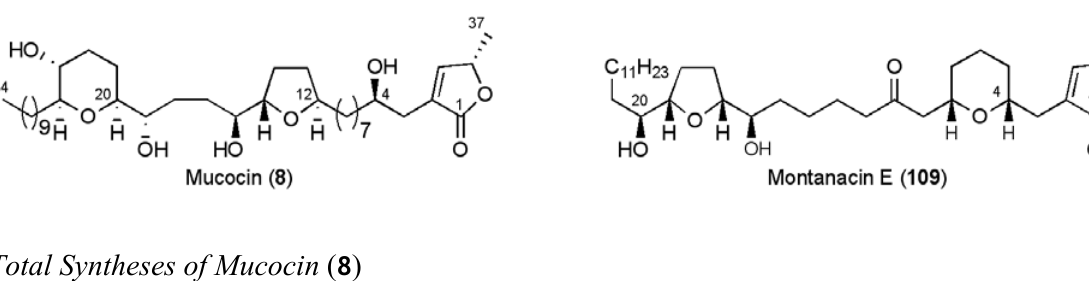
Figure 15. Structures of mucocin ( 8 ) and montanacin E ( 109